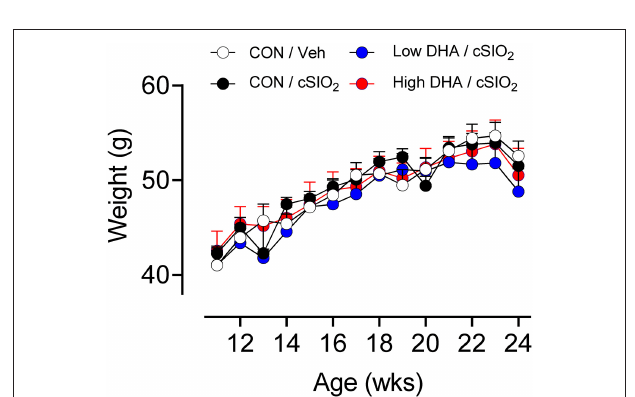
FIGURE 2 | Body weight change in NZBWF1 mice is not affected by cSiO 2 treatment and experimental diets. Animals in Cohort 1 were weighed weekly following the final cSiO 2 instillation. Data presented as mean ± SEM. Differences between CON/Veh and CON/cSiO 2 were assessed by Student’s T -test. Low DHA/cSiO 2 and high DHA/cSiO 2 were compared to CON/cSiO 2 using one-way ANOVA followed by Dunnett’s post-hoc test. At each time point, we observed no significant differences between treatment